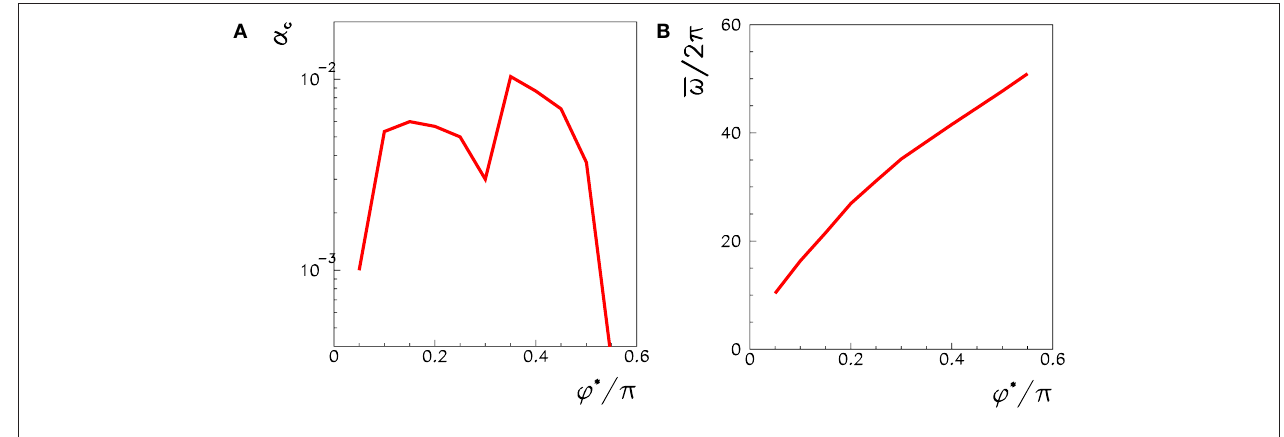
Figure 7 | (A) Maximum capacity α connected spiking IF neurons, as a function of the learning window asymmetry ϕ * . The spontaneous dynamics induced by a short train of M = 300 spikes with